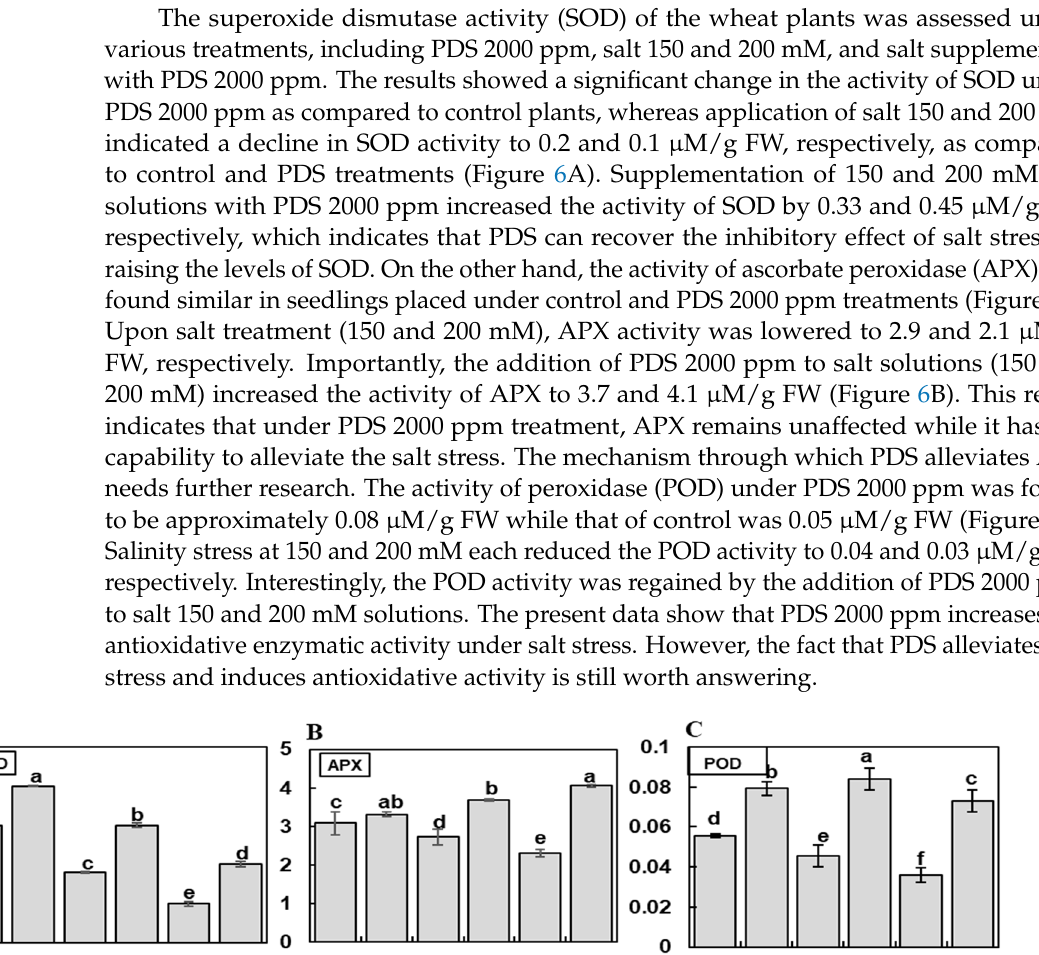
8 of 16 Figure 5. Effect of PDS on reactive oxygen species (ROS) (H 2 O 2 ) under normal and salt stress. ( A ) The level of H 2 O 2 was determined under PDS (2000, 1000, and 500 ppm). ( B ) Salt (150 and 200 mM), and salt supplemented with PDS 2000 ppm. Seven-day-old seedlings were harvested and subjected for the analysis of H 2 O 2 . Five seedlings were randomly selected from each treatment and H 2 O 2 was assessed. ( C ) Lipid peroxidation was analyzed in terms of TBARS using 7-day-old seedlings. Five